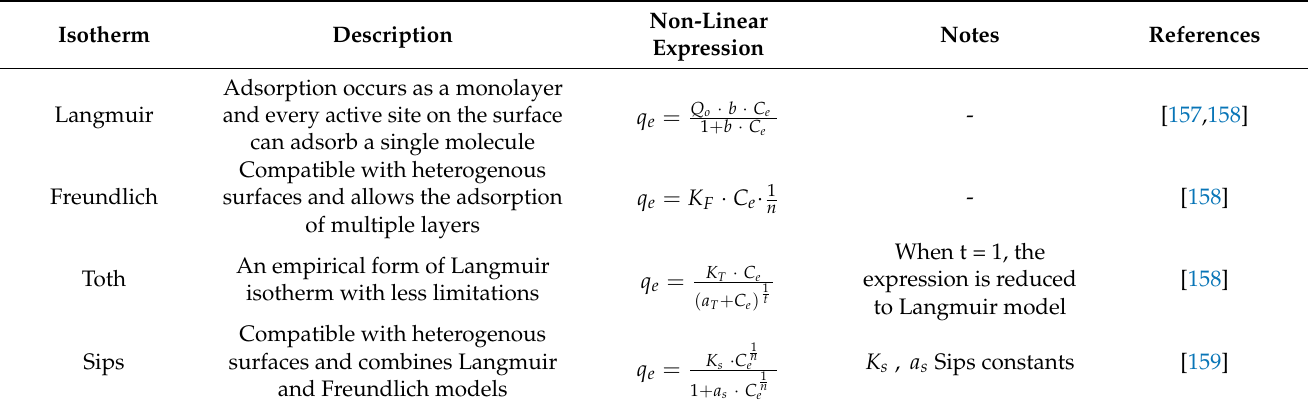
Table 6. Summary of the major adsorption